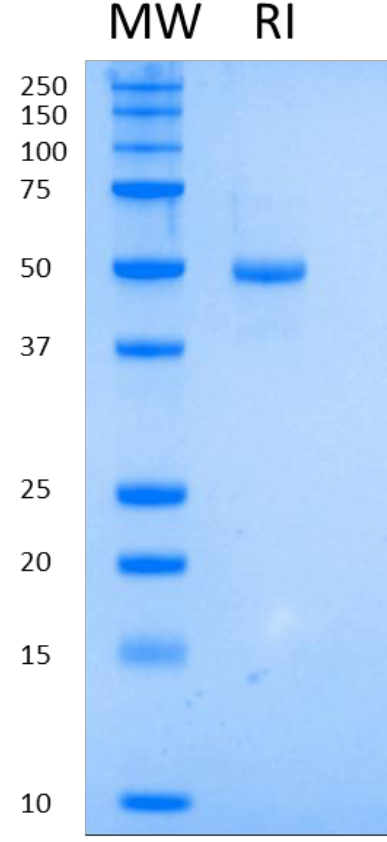
Figure 1. Purified RI run on SDS-PAGE.